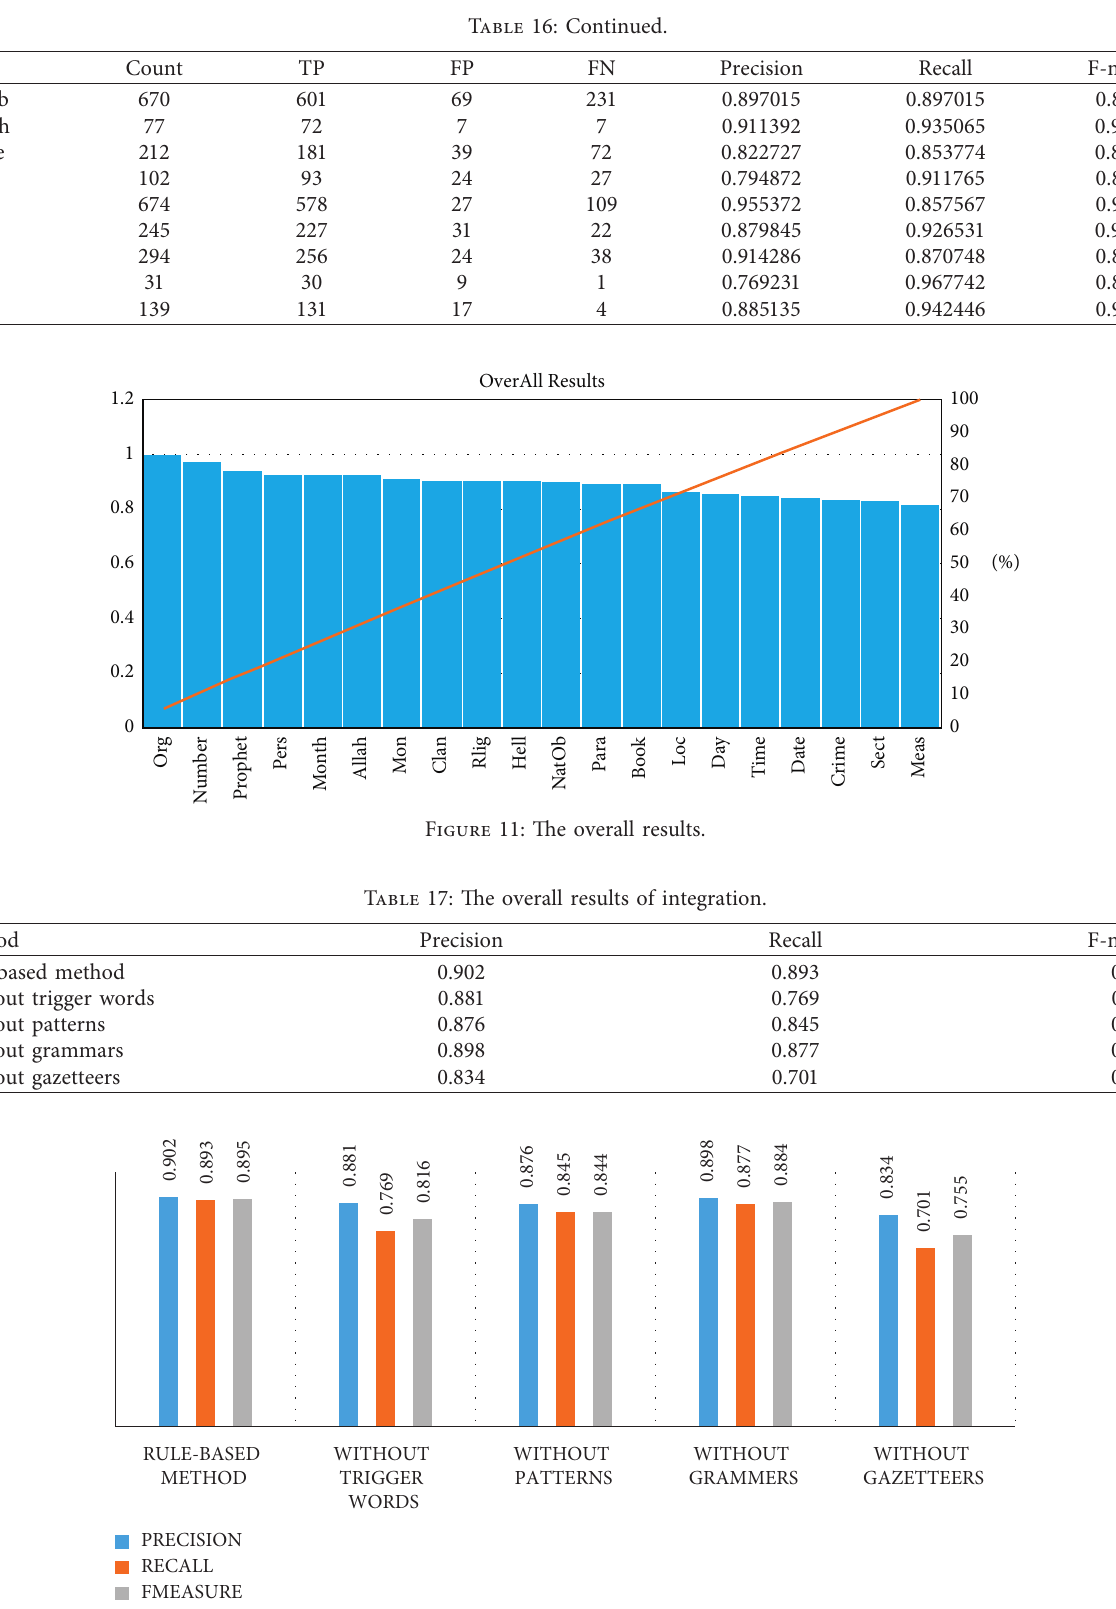
Figure 12: Comparison of versions of the rule-based